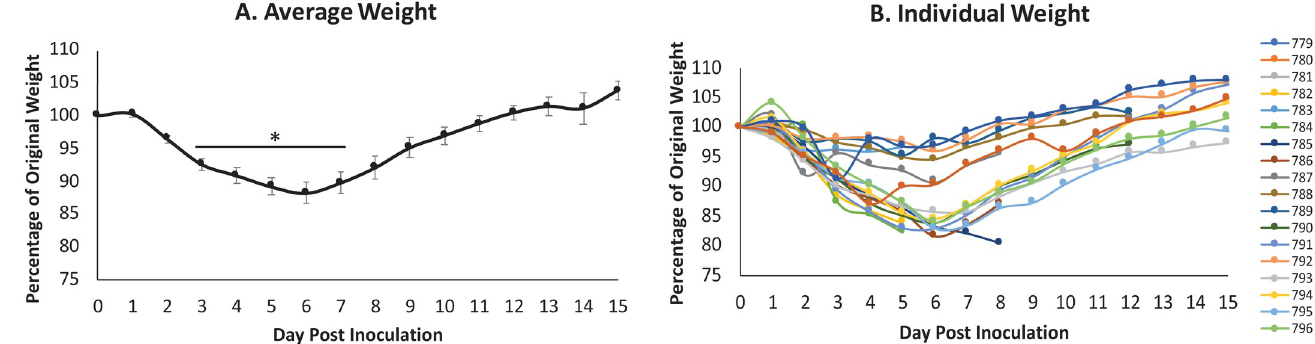
Fig 1. Intranasal SARS-CoV-2 infection in hamsters leads to significant weight loss. Syrian hamsters were intranasally inoculated with the severe acute respiratory syndrome coronavirus 2 (SARS-CoV-2) at 10 5 TCID 50 . Weight (A and B) was recorded for 15 days post inoculation. Average results (A) show the mean. Individual results represent each animal (B). � indicates a p-value < 0.05 determined by ANOVA comparing hamsters on the days post inoculation to baseline (day 0). Error bars indicate +/- standard error (SE).